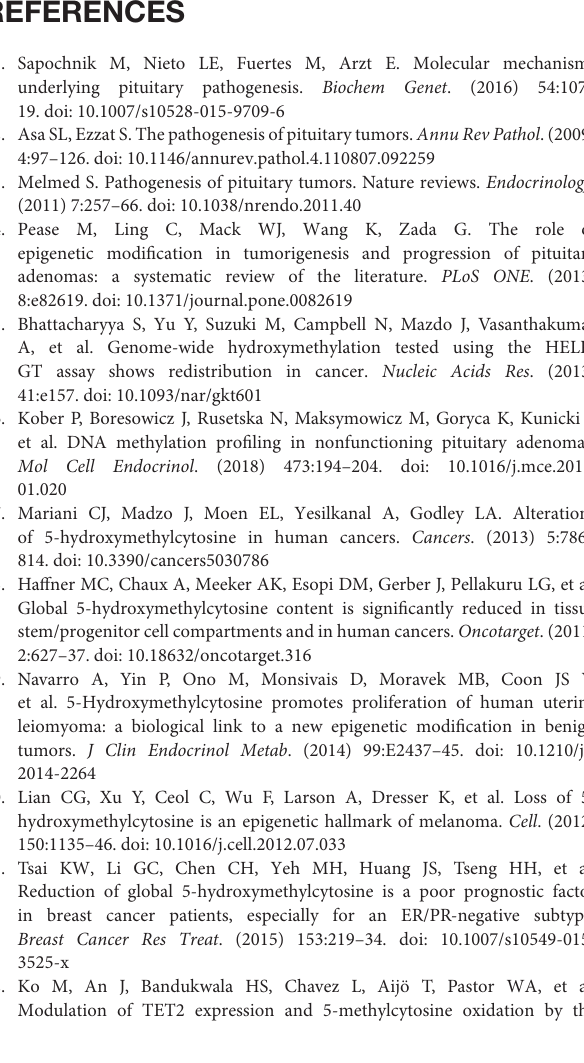
invasion by ROC curve analysis. The areas of ROC curves were 0.595 ± 0.088 ( P = 0.300) and 0.668 ± 0.087 ( P = 0.068). Genomic 5hmC or 5caC levels cannot be used to identify NFPA invasion. Supplementary Figure 2 | TET2 expression and localization in invasive and non-invasive NFPAs. A total of 26 NFPAs analyzed by TET2 immunohistochemistry were separated into invasive and non-invasive groups. (A) Genomic 5hmC levels between the 2 groups were not significantly different [0.44 ‰ (0.30 ‰ , 0.62 ‰ ) vs. 0.23 ‰ (0.15 ‰ , 0.63 ‰ ), P = 0.363]. (B-D) TET2 total, nuclear and cytoplasmic expression in the 2 groups was also not significantly different (165.74 ± 87.44 vs. 158.33 ± 71.57, P = 0.815, 108.52 ± 50.06 vs. 95.95 ± 46.78, P = 0.522, 57.22 ± 39.39 vs. 62.39 ± 27.87, P = 0.698). Supplementary Figure 3 | TET2 variations and amino acid sites in the protein. There were 3 SNP variations in nucleotide sequences and amino acid sequences. (A–C) Showed wild type. (D–F) Showed SNP sites. ∗ Represented variation sites. (G) TET2 p.P29R is located in the N-terminus. TET2 p.L1721W and TET2 p.I1762V are located in a non-conserved region of double-stranded β -helix (DSBH). A portion of the picture is from Mohr et al. (14). Supplementary Table 1 | Primers for TET2 coding